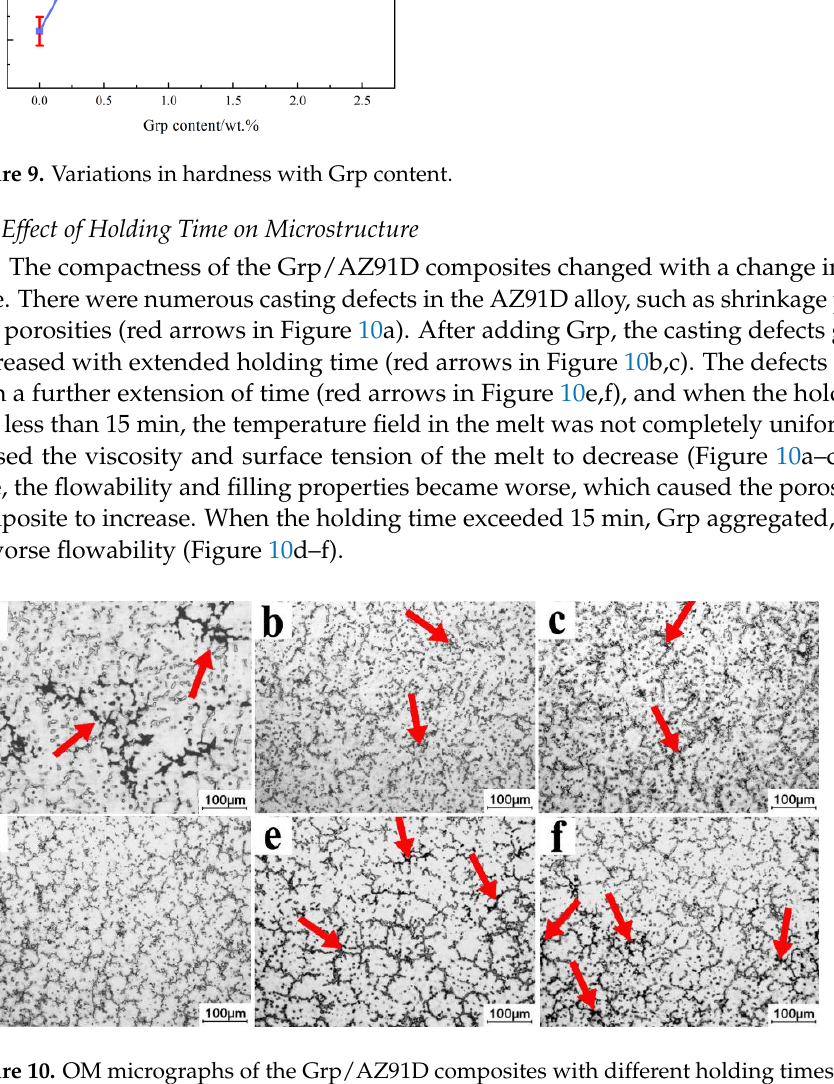
Figure 11. OM micrographs of as-solution Grp/AZ91D composites with different holding times: ( a ) 0 min, ( b ) 5 min, ( c ) 10 min, ( d ) 15 min, ( e ) 20 min, and ( f ) 30 min.